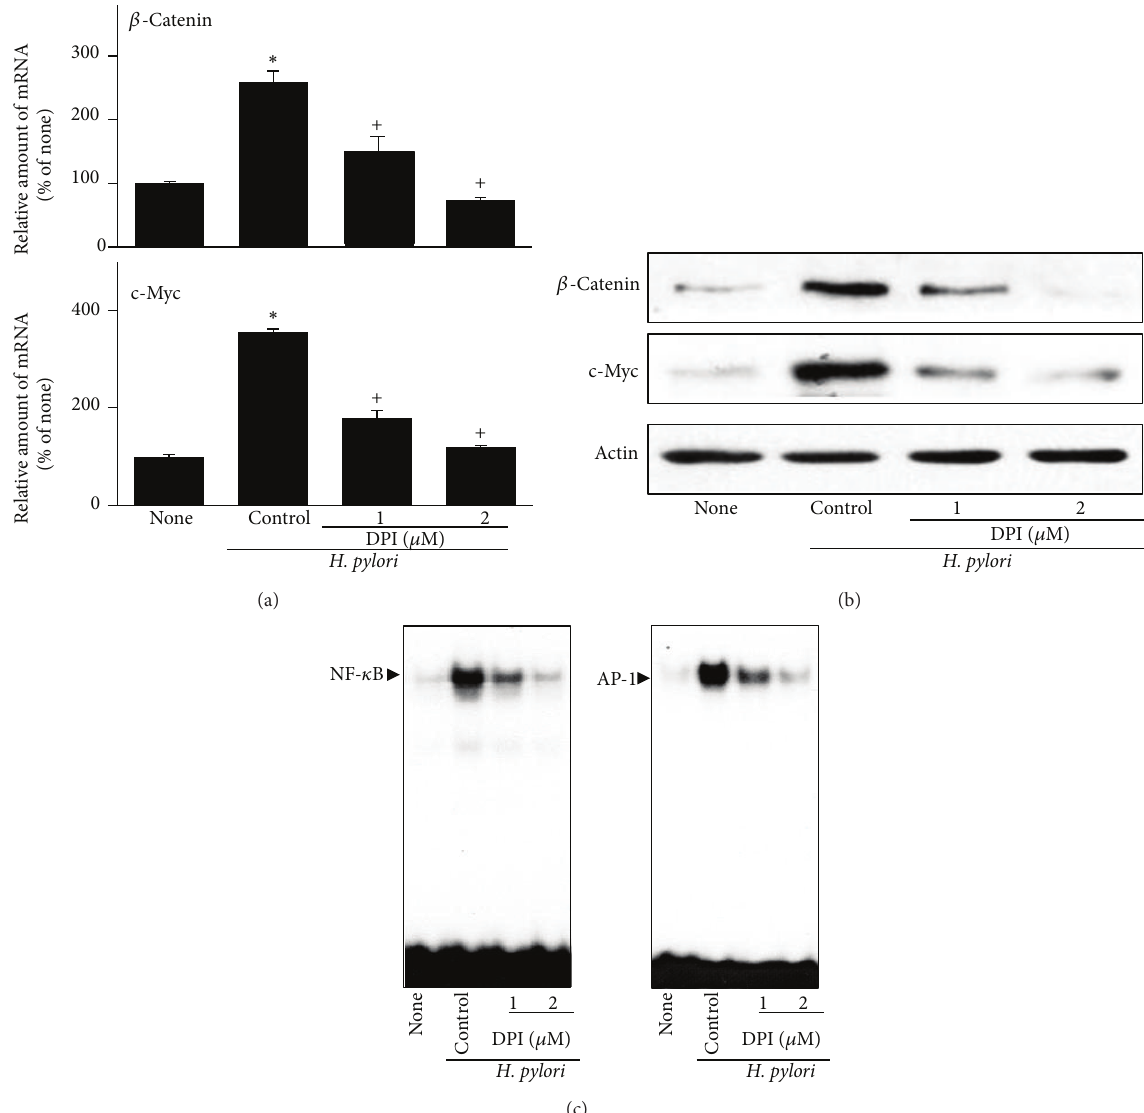
Figure 8: Effect of DPI on expression of 𝛽 -catenin and c-myc as well as activation of NF- 𝜅 B and AP-1 in H. pylori- infected AGS cells. The cells were pretreated with DPI for 2h and cultured in the presence or absence of H. pylori for 24 h (mRNA, protein levels) or 1h (activation of NF- 𝜅 B and AP-1). (a) mRNA expression of 𝛽 -catenin and c-myc was measured by real-time PCR analysis. (b) Protein levels of 𝛽 -catenin and c-myc were determined by Western blot analysis. Actin served as a loading control. (c), EMSA was performed for DNA binding activities of NF- 𝜅 B and AP-1. ∗ 𝑃 < 0.05 versus corresponding none (the cells cultured in the absence of H. pylori ); + 𝑃 < 0.05 versus corresponding H. pylori control (the cells cultured in the presence of H. pylori and treated without